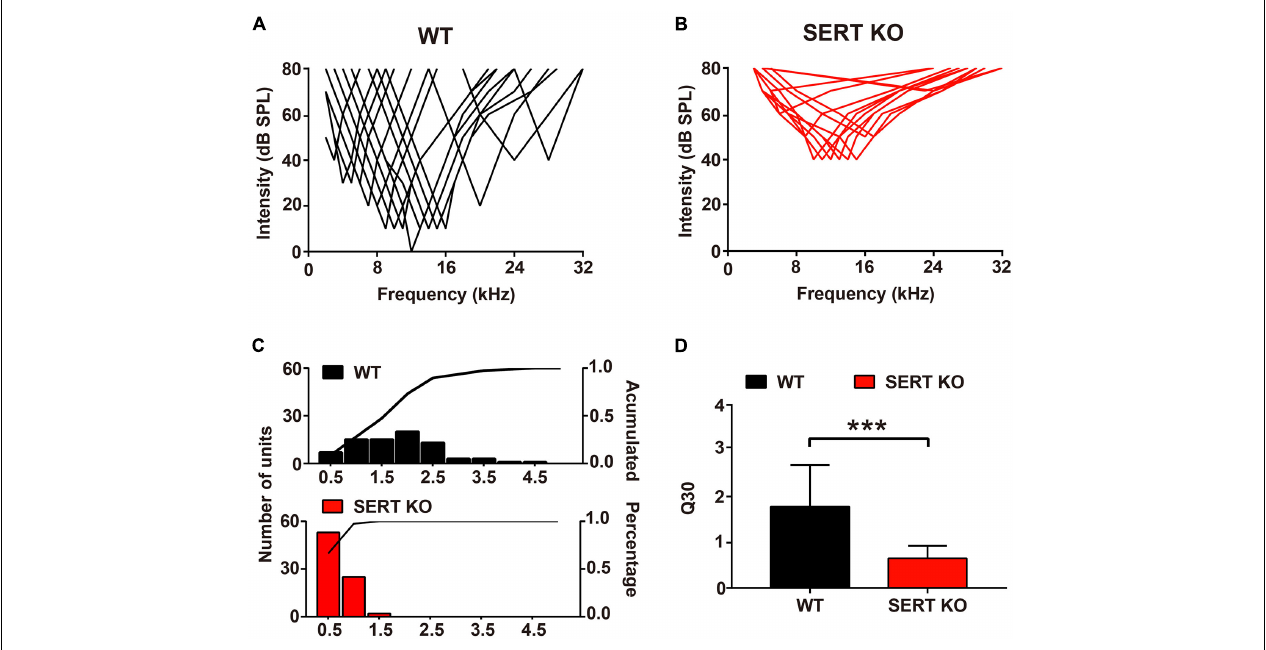
FIGURE 6 | Broader frequency tuning for primary auditory cortical neurons in serotonin transporter (SERT) knockout (KO) mice. Pooled data show the frequency-tuning curves of cortical neurons in wild-type (WT) (A) and SERT KO (B) AI. (C) The distribution of the Q30 values for cortical neurons in WT (top panel) and SERT KO (bottom panel) AI. The lines in the panels represent the cumulative percentage of the Q30 value. (D) The mean Q30 value of all auditory neurons recorded from WT mice and SERT KO AI. Data are presented as means ± SD. n = 6 for each group. *** p < 0.001. Student’s t